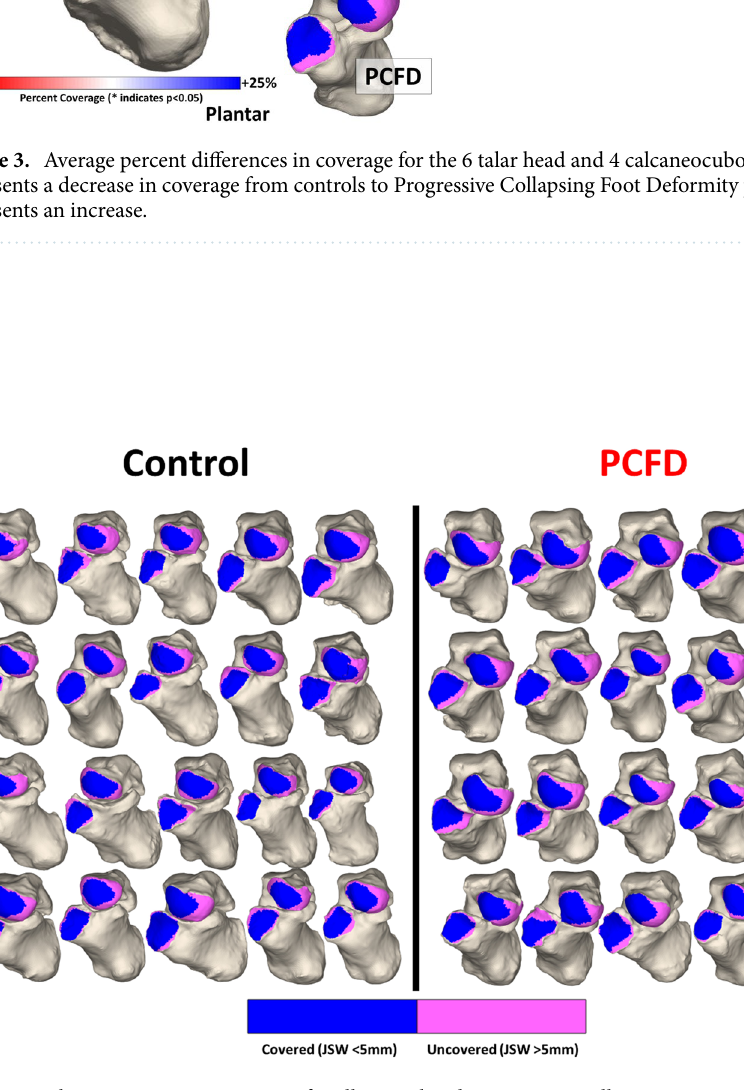
Figure 4. Chopart joint coverage maps for all control and Progressive Collapsing Foot Deformity feet. The navicular and cuboid are removed to show an anterior view of the talar head and calcaneocuboid facet. Pink indicates regions of uncoverage while blue represents regions of